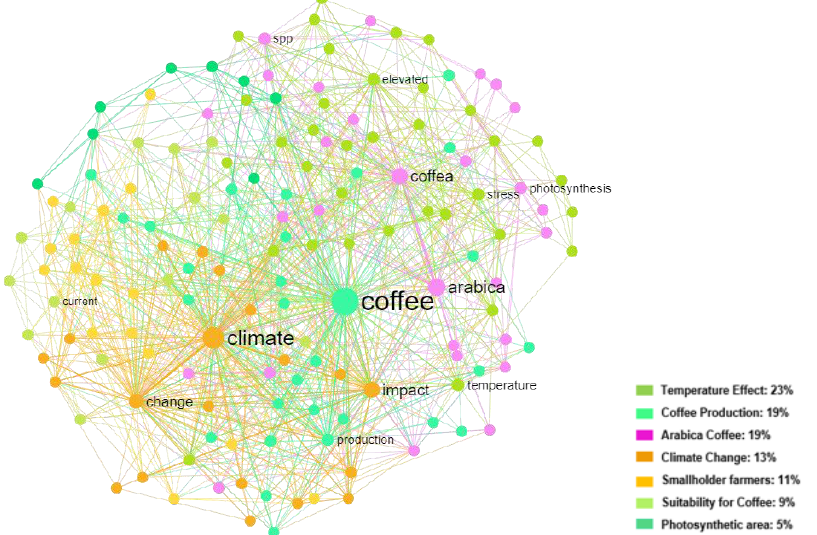
Figure 3. Concept network mapping for references’ titles screened for the final review and the cor- responding keywords. The main topical clusters are shown on the map legend, each of which is distinguished by a particular colour. Thus, the three factors that have the largest influence—represented by the larger circles—are coffee, climate, and Arabica.